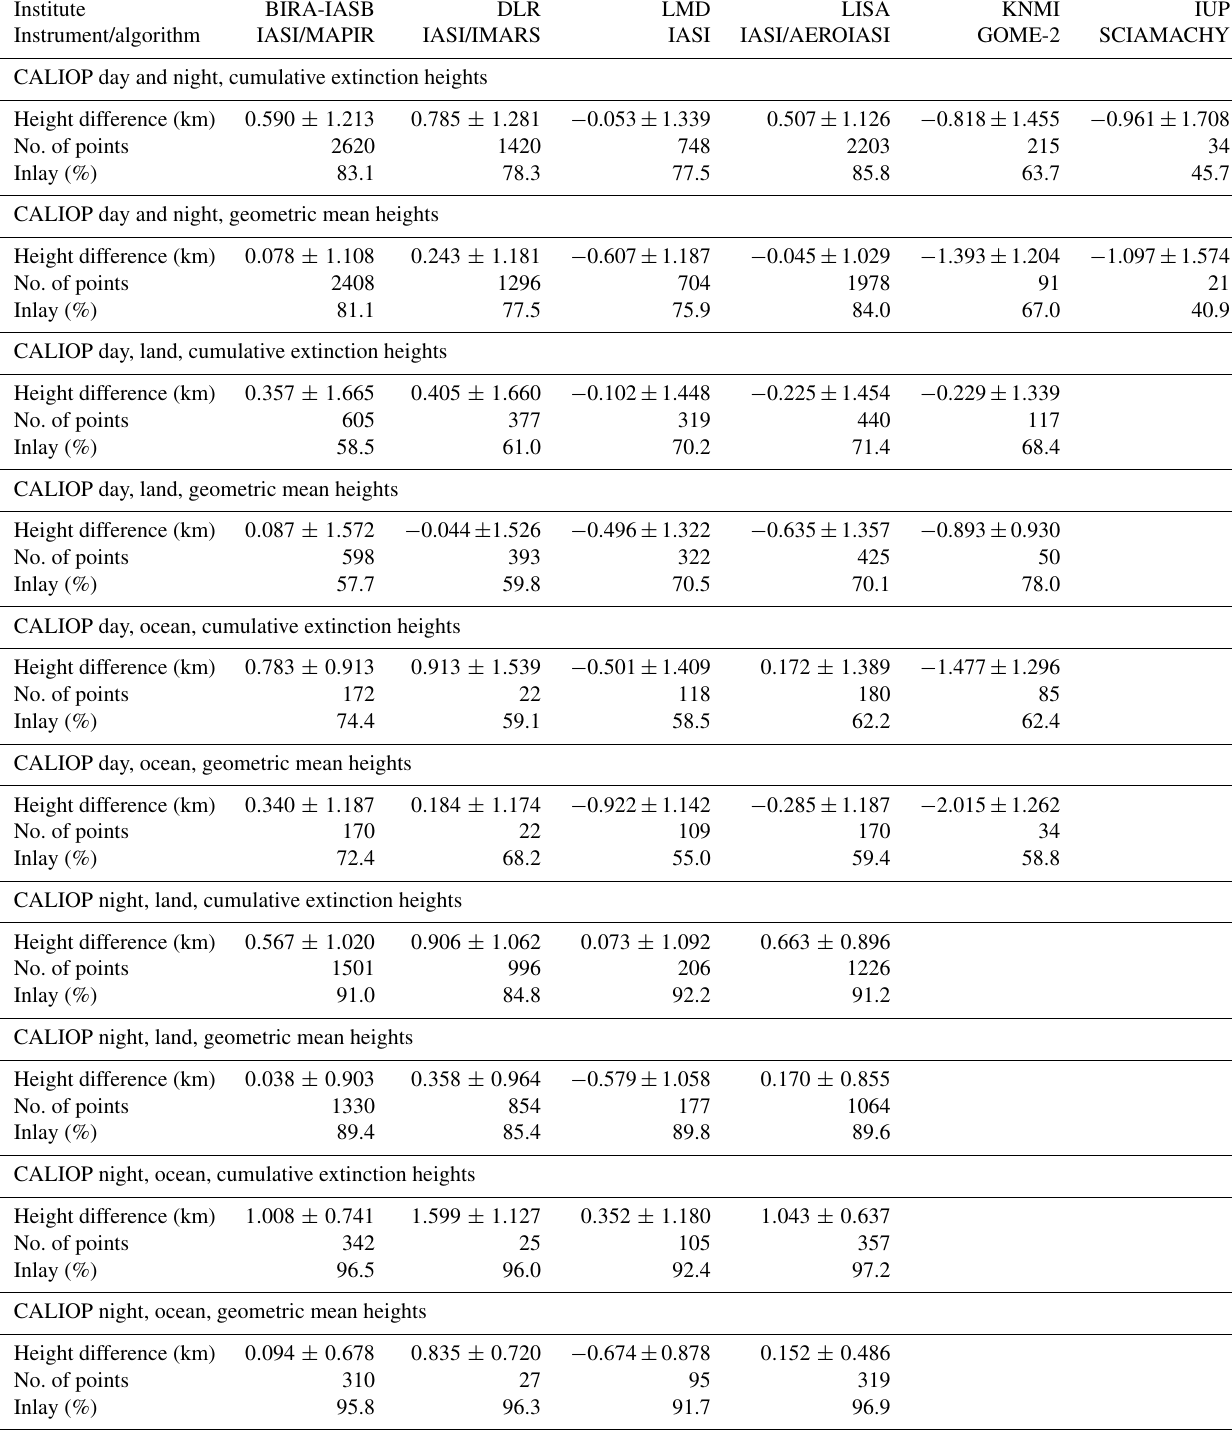
Table 3. The mean ± the standard deviation of the dust height difference between the passive sensors and CALIOP, and the number of co-located points. The inlay is the percentage of heights that are within the CALIOP layer. For BIRA-IASB, DLR, LISA and LMD statistics are given for all data and subgroups of data recorded during daytime and night-time and over land and ocean. For KNMI-GOME2 only day comparisons are possible, hence the lack of comparisons with CALIOP night overpasses. Also note that for KNMI-GOME2 the number of land and ocean pixels does not add up to the total due to some pixels covering coastal regions (mixed